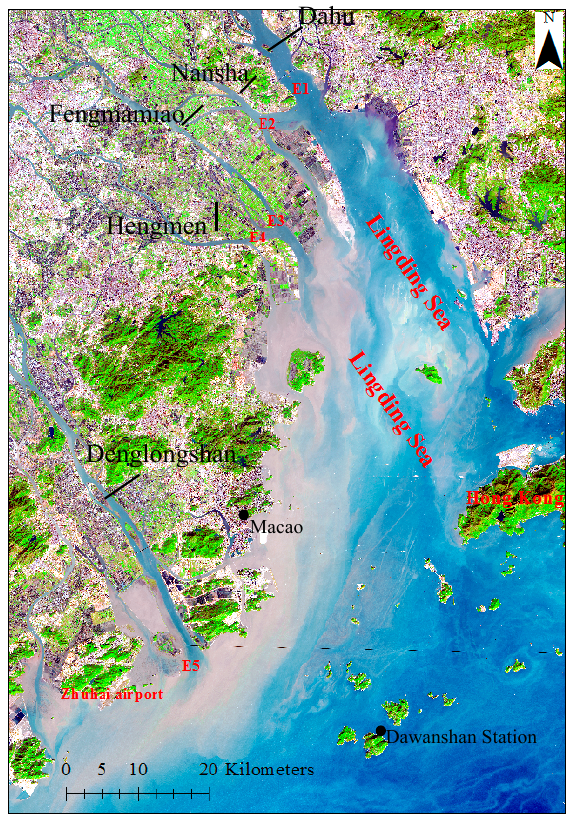
Figure 2. The sketch map of the study area (E1: Humen Estuary; E2: Jiaomen Estuary; E3: Hongqimen Estuary; E4: Hengmen Estuary; E5: Modaomen Estuary), and the upstream boundaries.